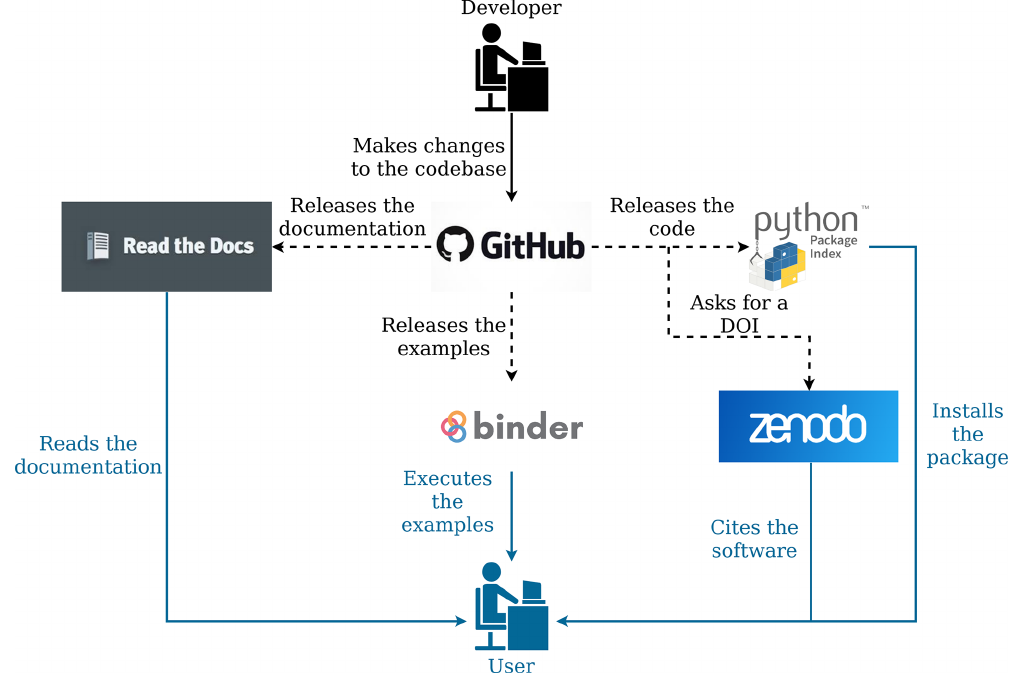
Figure 13. Organization of the SuperflexPy project, indicating the online software management tools used to develop the source code and documentation, release product versions with associated DOIs, and provide general open access to all project components. Typical workflow paths for users and developers are shown, respectively, in the blue and black lines and font. Dashed lines represent automated